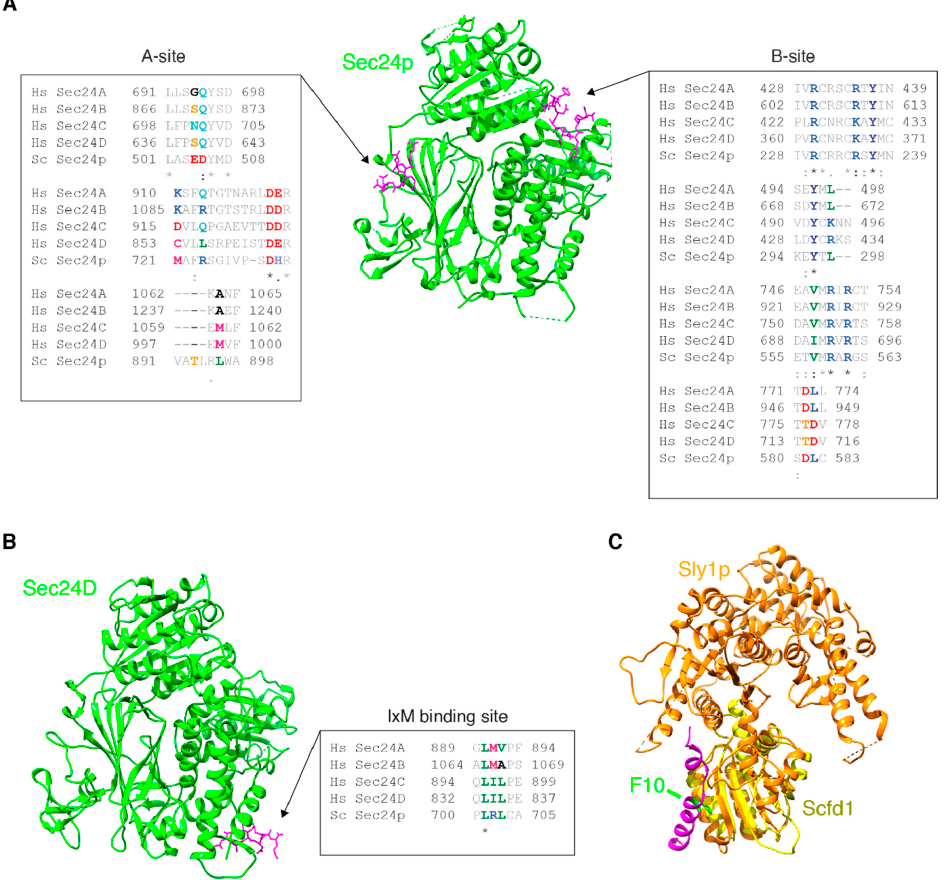
Figure 4. Interactions of Stx5 / Sed5p with Sec24 and Scfd1 / Sly1p. ( A ) Crystal structure of yeast Sec24p (green) bound to the YNNSNPF motif of Sed5p (A-site) and the LxxME motif of Bet1p (B-site) [63]. Alignments of interacting regions of Sec24p with mammalian Sec24A–D are shown. Substrate-interacting residues are in bold and colored. Note that the A-site is not conserved, whereas the B-site seems conserved in mammalian Sec24A and B (not C and D). ( B ) Crystal structure of mammalian Sec24D (green) with the IxM motif of Stx5 (magenta; residues 241–248) [62]. Note that the IxM binding site is not conserved in mammalian Sec24A–D. ( C ) Conserved interactions between Stx5 / Sed5p and Scfd1 / Sly1p. Crystal structure of yeast Sly1p (orange) with the N-terminal region of Sed5p (magenta; residues 1–21) [61] aligned with an NMR structure of mammalian Scfd1 (yellow) [60]. Interacting residue F10 of the short isoform of Stx5 and Sed5p is indicated